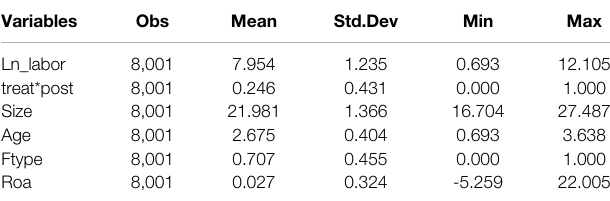
TABLE 1 | Descriptive statistics of